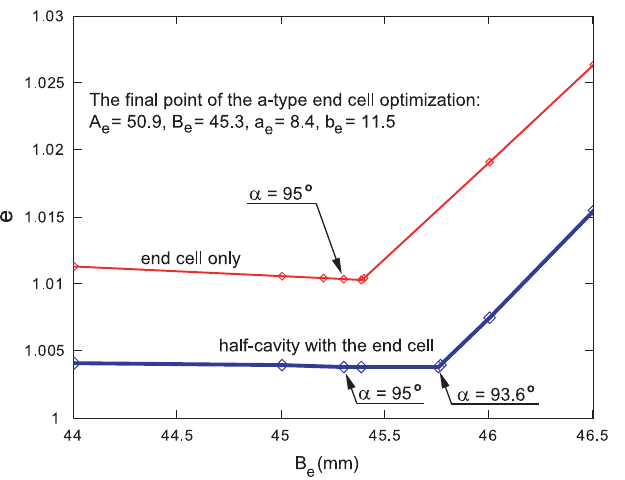
FIG. 11. (Color) Normalized electric field e vs B ¼ b ¼ 6 mm for the type b end a e e